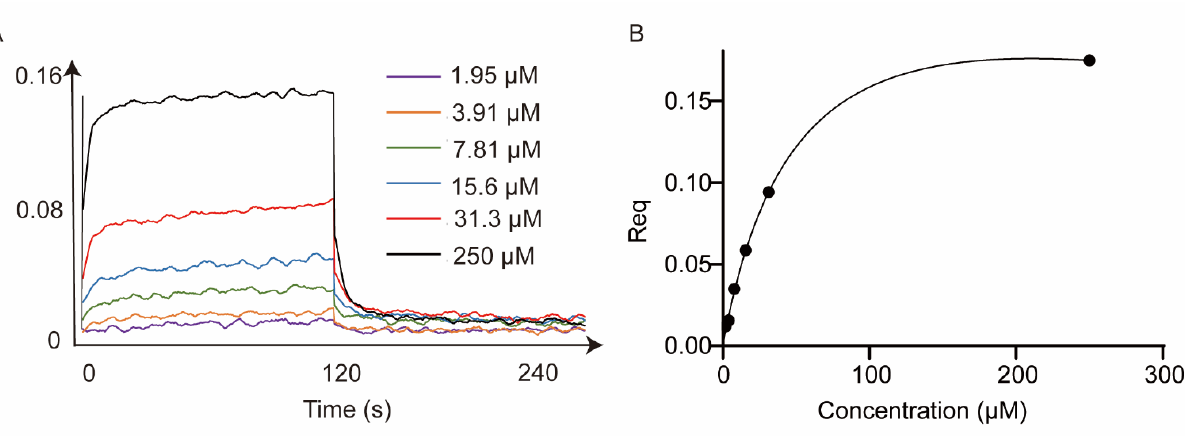
Figure 10. Kinetic analysis of compound 5c against STAT3. ( A ) A BLI assay was conducted on the SARTORIUS Octet R8 instrument utilizing SSA biosensors. Kinetic curve fitting and KD calculation were performed by SARTORIUS Octet Evaluation HT 12.0 Software. ( B ) Saturation binding curve derived from the steady-state values of the sensorgram curves shown in ( A ). The req values were derived by calculating the average of data points collected during the 0 to 120 s window of the association step. Values are presented as the means ± SDs from three independent experiments. ns = not significant.